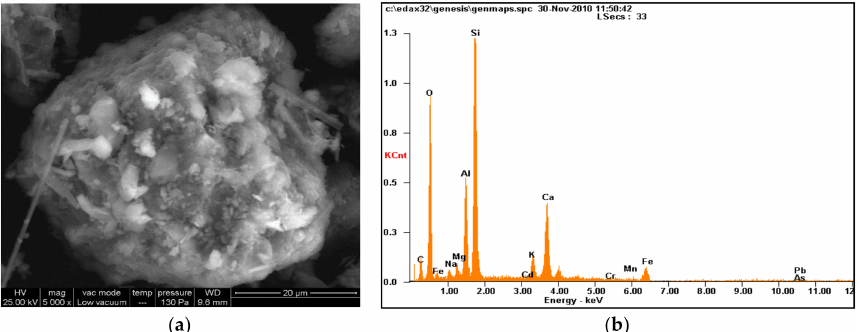
Figure 4. Scanning electron micrograph of IS-T soil particle at 20 µ m ( a ) and corresponding EDS spectrum ( b ).